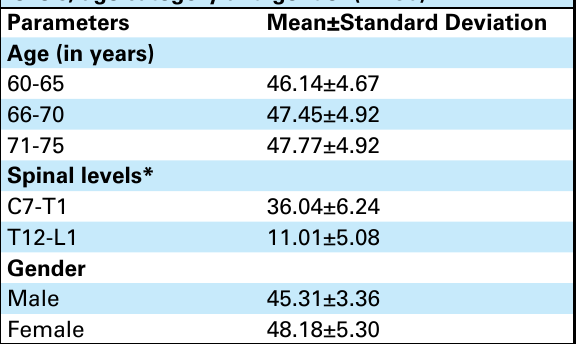
Table 1. Hyperkyphosis angle at different spinal levels, age category and gender (n=